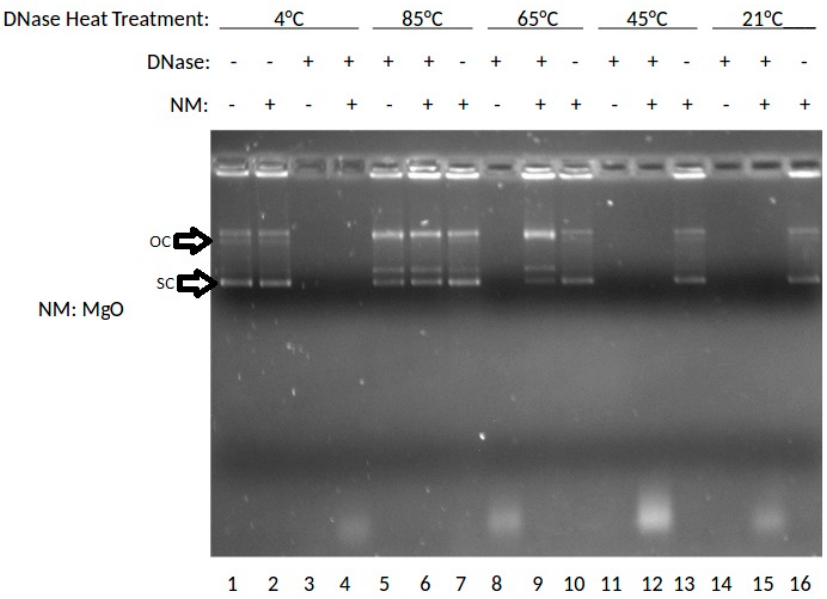
Figure 1. Effects of MgO on DNase activity at various temperatures shown by gel electrophoresis.